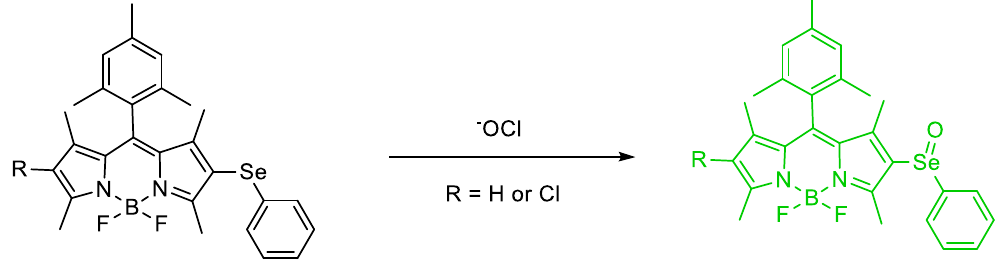
Figure 37. Structures of BODIPY based probes for the detection of − OCl by Mulay et al. The squaraine dyes are an important class of fluorophore. Dicyanomethylene squaraine dyes have a 665–716 nm fluorescence emission which are intense and narrow (Figure 38). Compound 7f in their article is of appreciable interest considering this discussion [76].